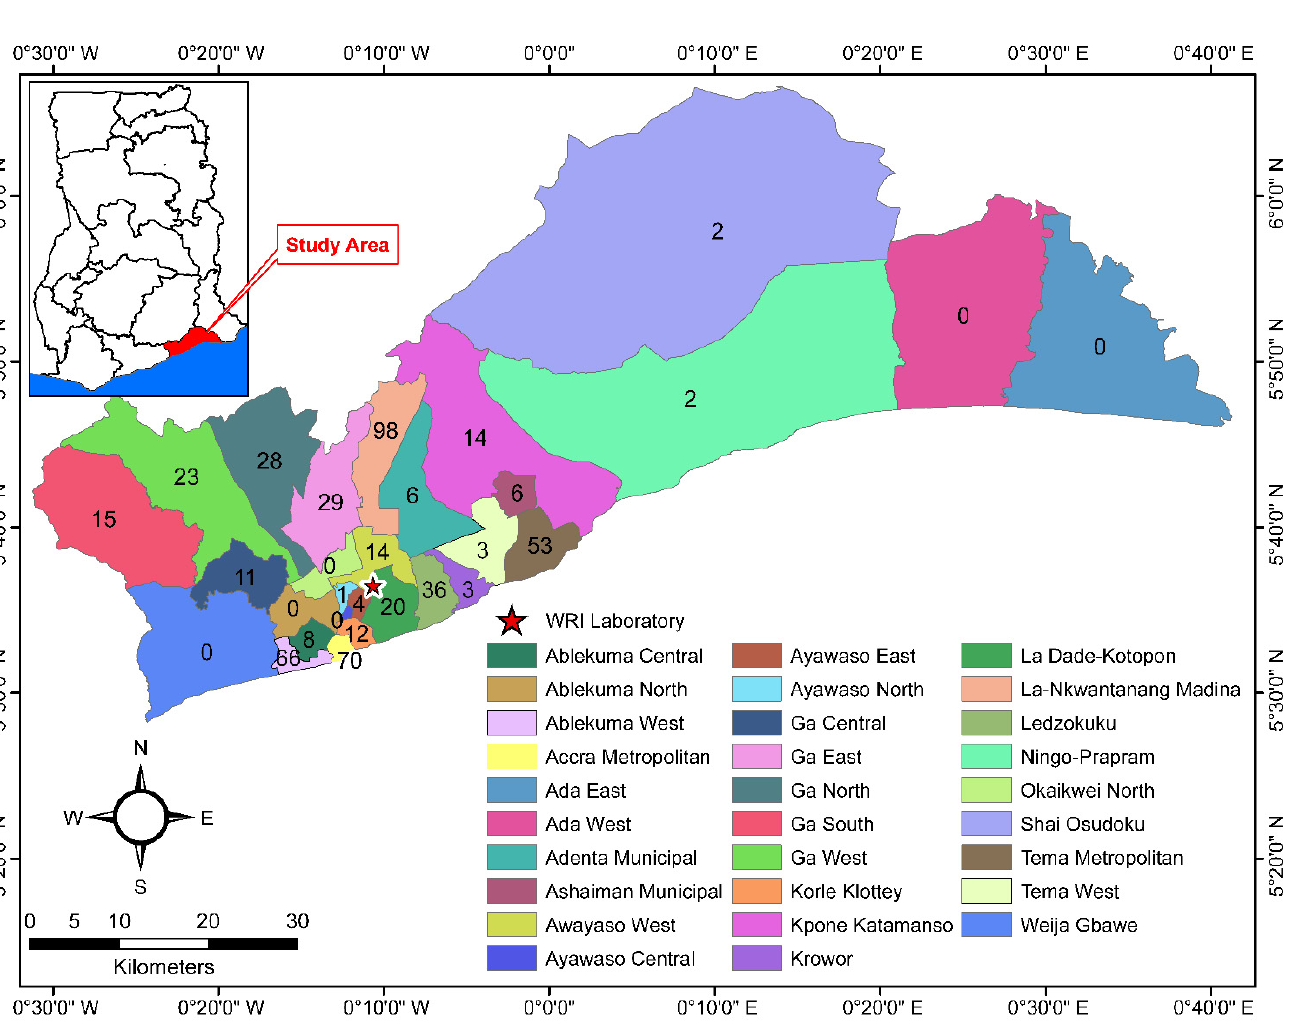
Figure 1. Map of Greater Accra region, Ghana, showing sample source locations and number of drinking water samples received and tested, December 2021–March 2022. WRI: CSIR–Water research Institute laboratory in Accra. Numbers indicate the number of samples received from each